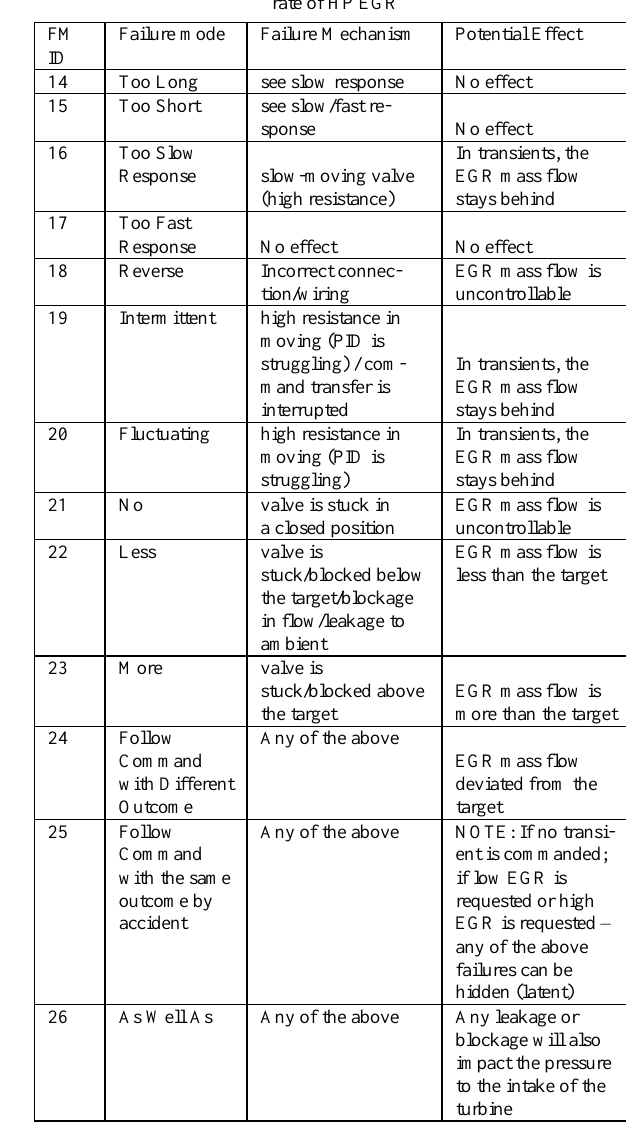
Table 5. FMEA of H-EGR valve element, function: controls recirculation rate of HP EGR